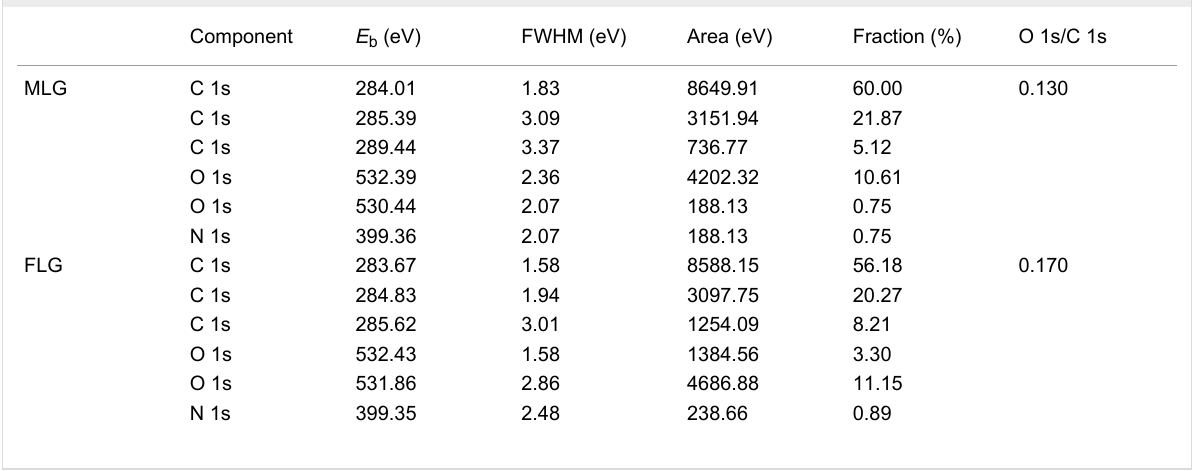
Table 1: Chemical composition of MLG and FLG from XPS